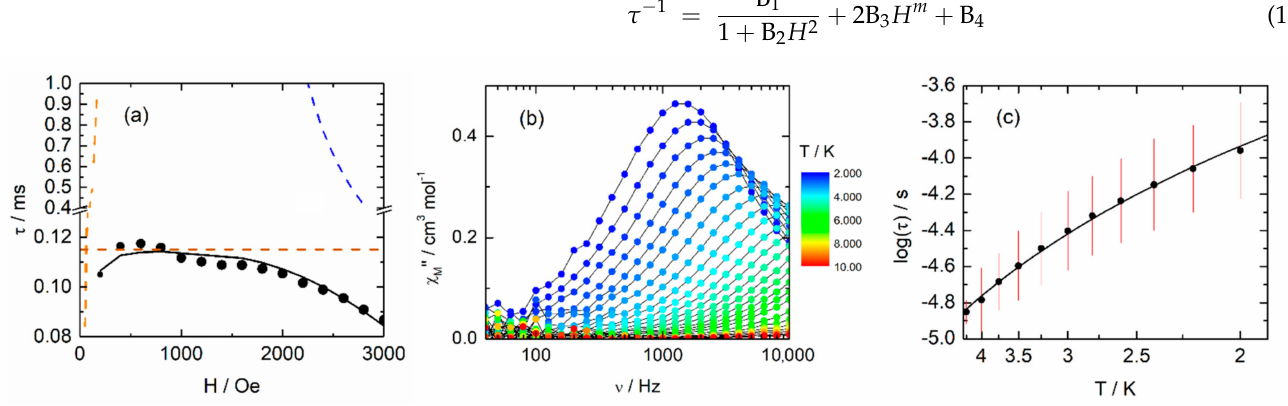
Figure 5. ( a ) Field dependence of the relaxation time at 2 K in the field range of 0–3000 Oe for 1 (size of the black dot is proportional to the slow relaxing fraction) with the best-fitted curve (full black line) with the combination Orbach + Raman (dashed brown line), QTM (dashed orange line) and direct (dashed blue line) processes. ( b ) frequency dependence of χ M ” for 1 at 1000 Oe in the temperature range 2–10 K; ( c ) temperature dependence of the relaxation time for 1 at 1000 Oe in the temperature range 2–4.25 K with the best-fitted curve (full black line) with Raman process only. Error lines are calculated using the log-normal distribution model at the 1 σ level